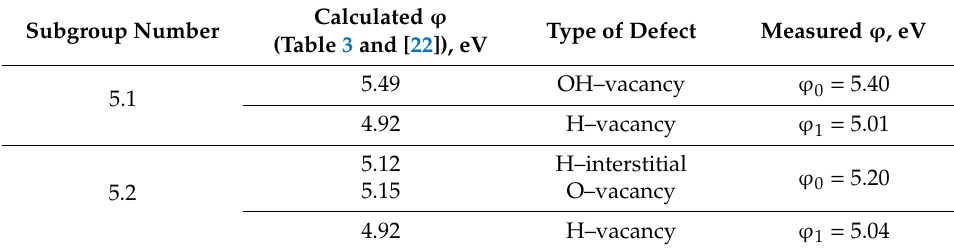
Table 12. Subgrouping of the samples of the group